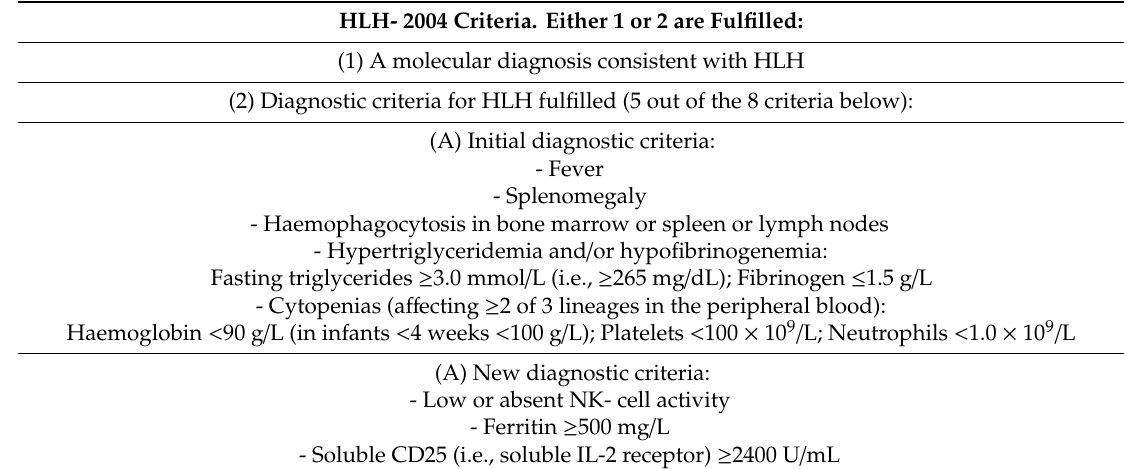
Table 3. Diagnostic guidelines for HLH. Adapted from Hayden et al.